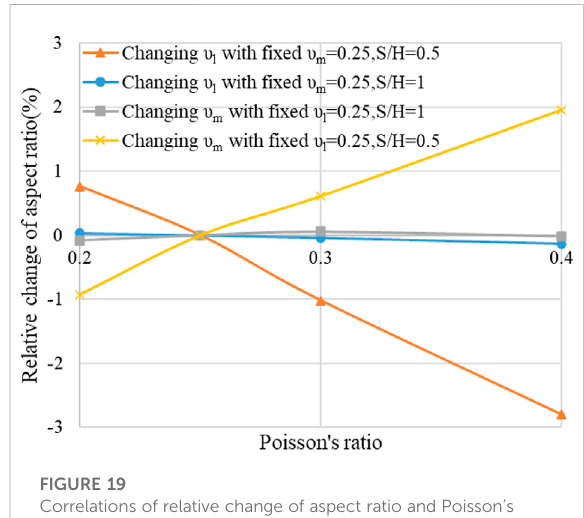
FIGURE 19 Correlations of relative change of aspect ratio and Poisson ’ s ratio in con fi ned fracture model (E m =E l =5 MPsi, ε xx (ave)=0.002, T l =H=0.2m, T m =0.3